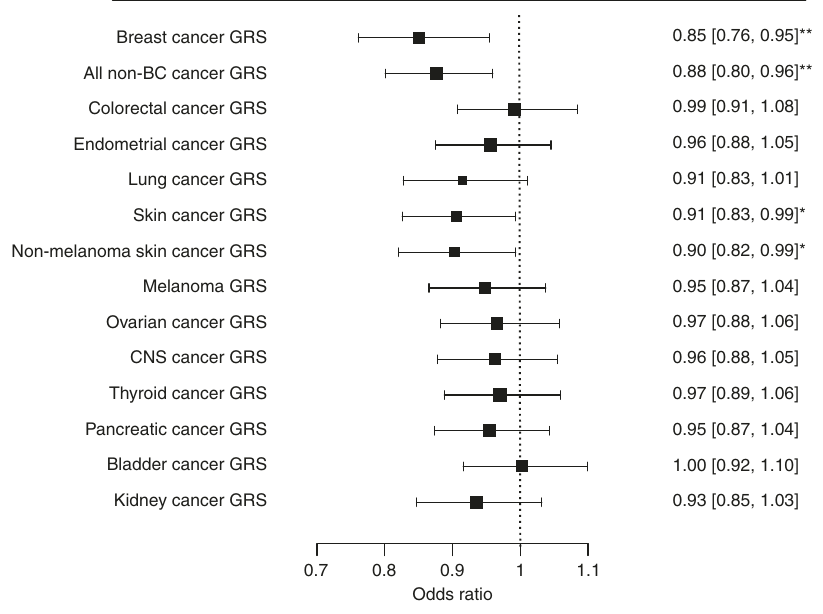
Fig. 2 Cancer genetic risk scores in interval breast cancer risk. Cancer genetic risk scores (GRS) were computed in Caucasian patients from the LIBRO-1 ( N = 1784), KARMA ( N = 1690) and WHI ( N = 1585) studies. The odds ratios of different cancer genetic risk scores (GRS) on interval breast cancer (IC) risk (black squares) compared with SDC as well as the 95% con fi dence intervals (CI, horizontal lines) were computed with logistic regression, adjusted for age at diagnosis, study and the fi rst three principal components. The exact estimates are given on the right-hand side of the plot with the accompanying 95% CI. The breast cancer GRS, skin cancer GRS, non-melanoma skin cancer GRS as well as the combined all cancer GRS computed from the cancer risk increasing alleles of 304 variants (excluding any variants in known BC loci) was statistically signi fi cantly associated with a protective effect on IC risk compared with SDC. The other cancer-speci fi c GRS were not signi fi cantly associated, although the majority of scores had a protective effect on IC. The GRS effect sizes are given per standard deviation of the score. * P < 0.05; ** P <